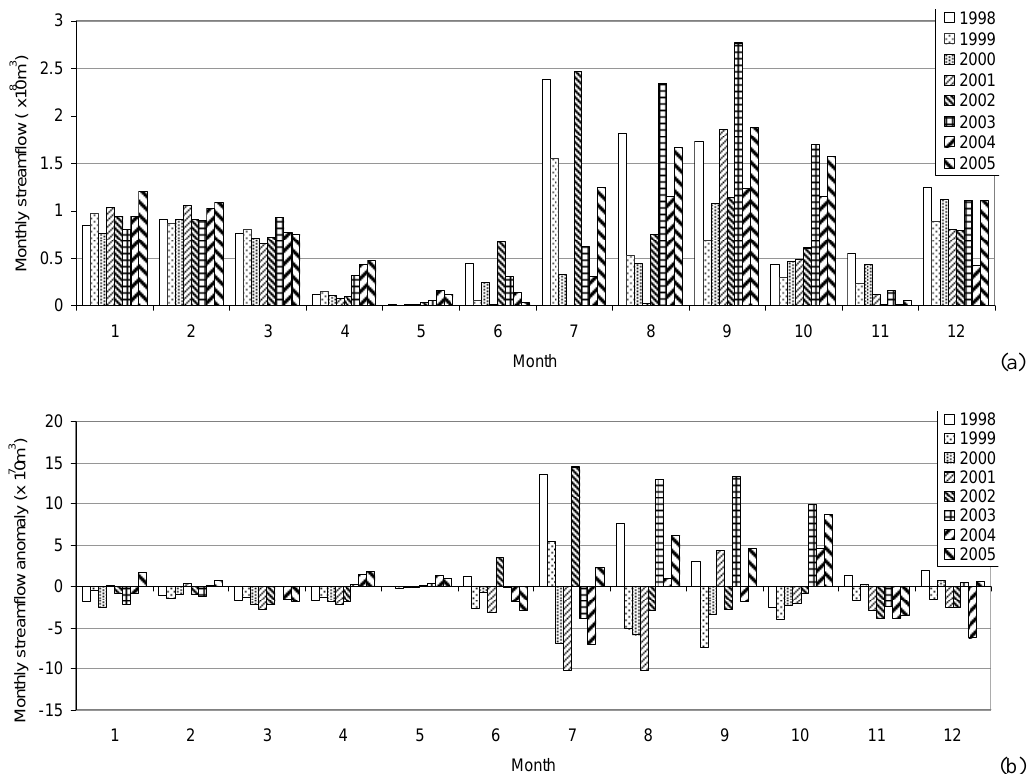
Fig. 6. (a) The monthly streamflow and (b) the anomaly of the monthly streamflow at Zhengyixia station from 1998 to 2004 (mean value was calculated between 1980 and 2005).